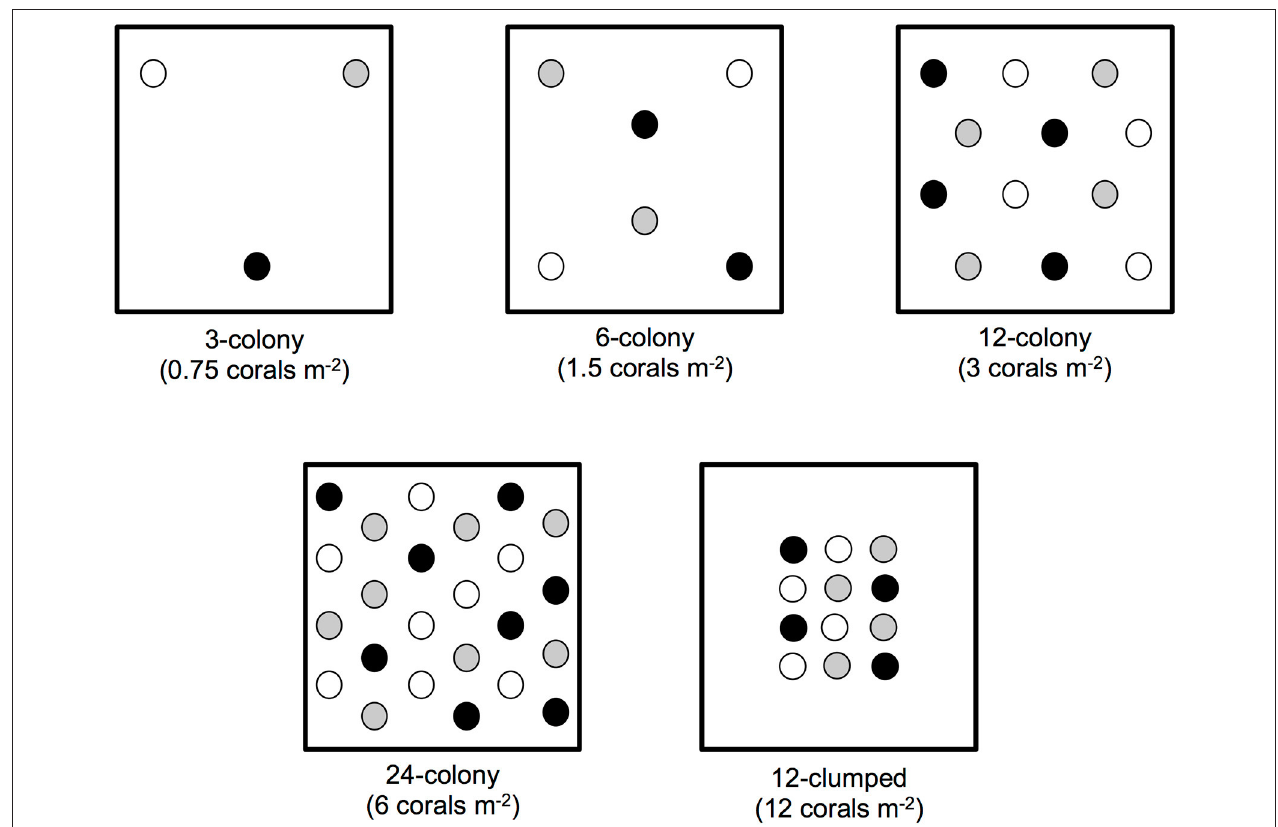
FIGURE 1 | Schematic of experimental design (to scale). Each dot represents an individual coral outplant, different shades indicate the three unique genotypes (K-1, K-2, and U24) used to establish experimental treatments.